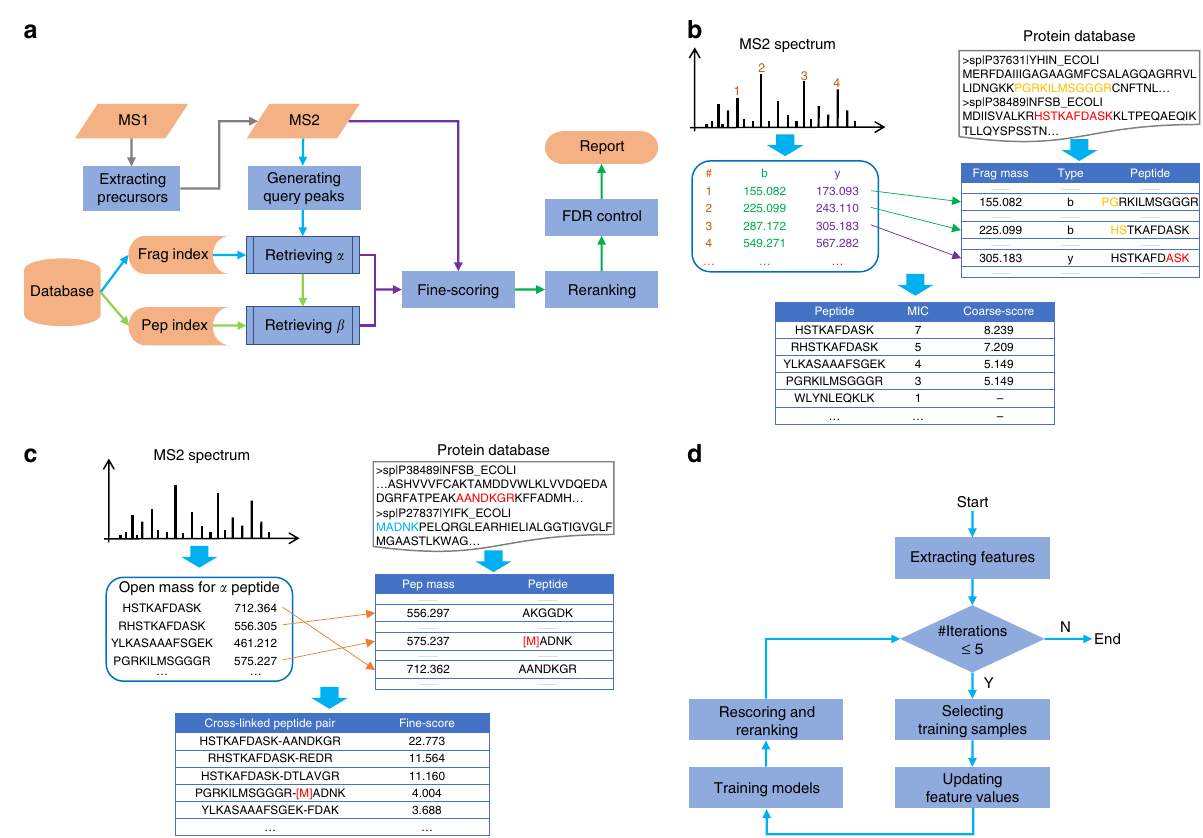
Fig. 1 pLink 2 work fl ow. a The general work fl ow. Step 1, MS1 scans are preprocessed by pParse to extract precursor candidates. Step 2, for each MS2 spectrum, α -peptide candidates are retrieved from the fragment index using query peaks generated from the spectrum. Step 3, β -peptide candidates are retrieved from the peptide index using the complementary masses of α -peptides. Step 4, α - and β -peptide candidates are paired and fi ne-scored with the MS2 spectrum. Step 5, all top scored PSMs are re-ranked and fi ltered after FDR control. b The sub-work fl ow of α -peptide retrieval. For each MS2 spectrum, the peaks are converted into regular b , y ions to query the fragment index. Only those peptides with at least two matched ions are coarse- scored with the spectrum and the top-5 coarse-scored α -peptide candidates are kept. c The sub-work fl ow of β -peptide retrieval. For each α -peptide candidate, the open mass is fi rst calculated by subtracting the α -peptide mass and the cross-linker mass from the precursor mass, and this mass is used to retrieve β -peptide candidates from the peptide index. Then, each of the fi ve α -peptide candidates is paired with each of its complementary β -peptide candidates and these pairs are fi ne-scored with the spectrum. Finally, the highest fi ne-scored peptide pair is kept. d The re-ranking algorithm. PSMs are grouped into intra-protein, inter-protein, loop-linked, mono-linked, and regular groups, and a semi-supervised learning algorithm is used to re-score and re- rank them in each